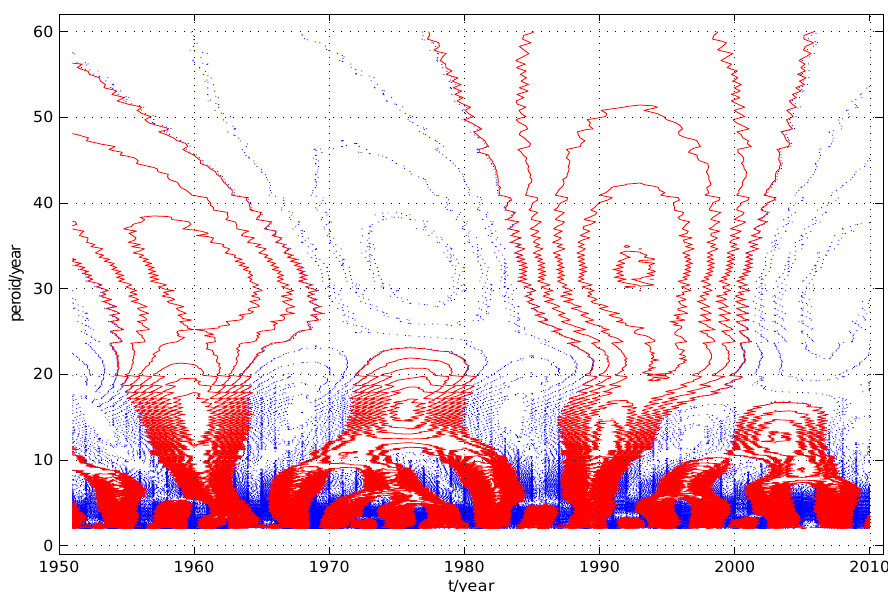
Figure 4. This contour is computed by using Zhao’s method with the Morlet wavelet parameter σ 2 = 1, η = 5 for Data